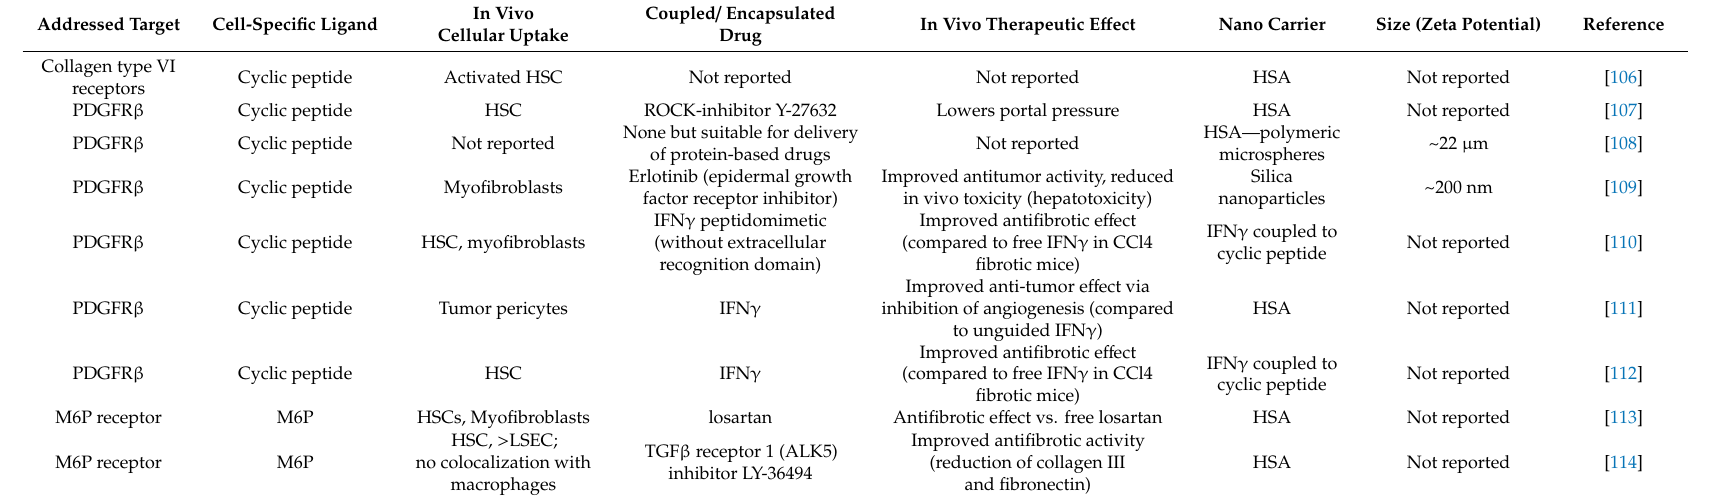
Table 1. Nanoligands for cell specific drug delivery to